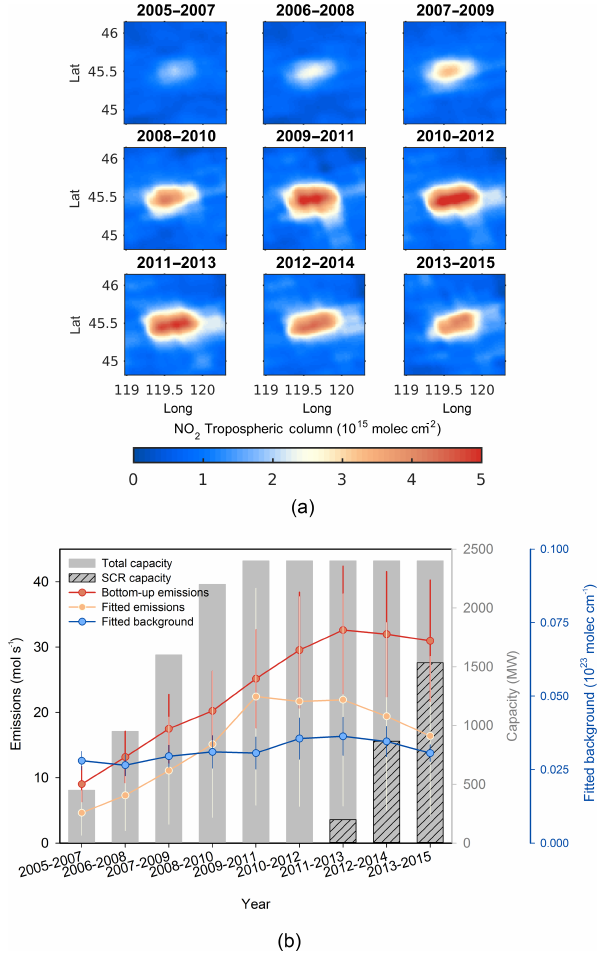
Figure 2. (a) OMI NO 2 TVCD map under weak-wind conditions (<3ms − 1 ) around the Huolin power plant (no. 2 in Fig. 1) during 2005 to 2015 and (b) the corresponding fit results. The red and blue lines denote the fitted emissions and background, respectively; the pink line denotes the bottom-up emission estimates; the solid and dashed bars denote the total capacity of the generation units and the capacity of generation units that installed SCR equipment, re- spectively. The information on the capacity and SCR equipment is derived from the CPED database (Liu et al., 2015). Error bars show the uncertainties for emissions by using this method and bottom-up inventories (see Sect.